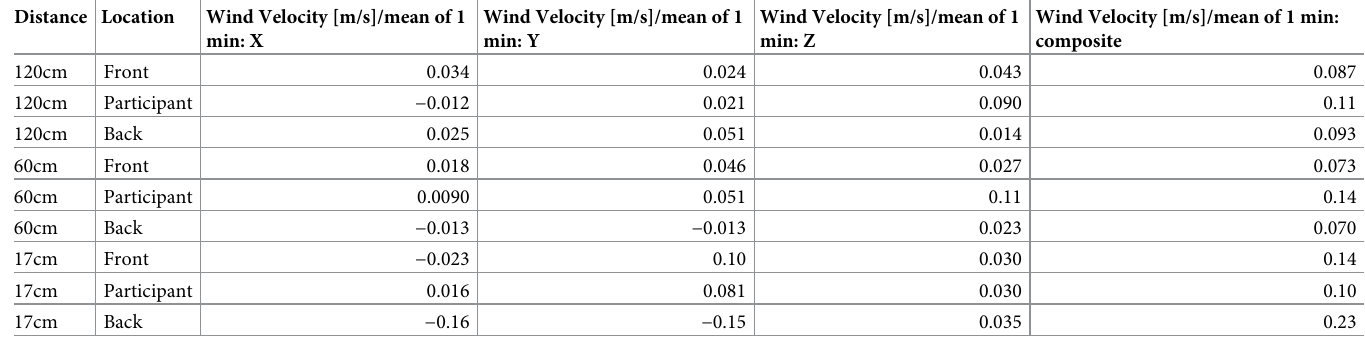
Table 2. Wind velocity under the indirect